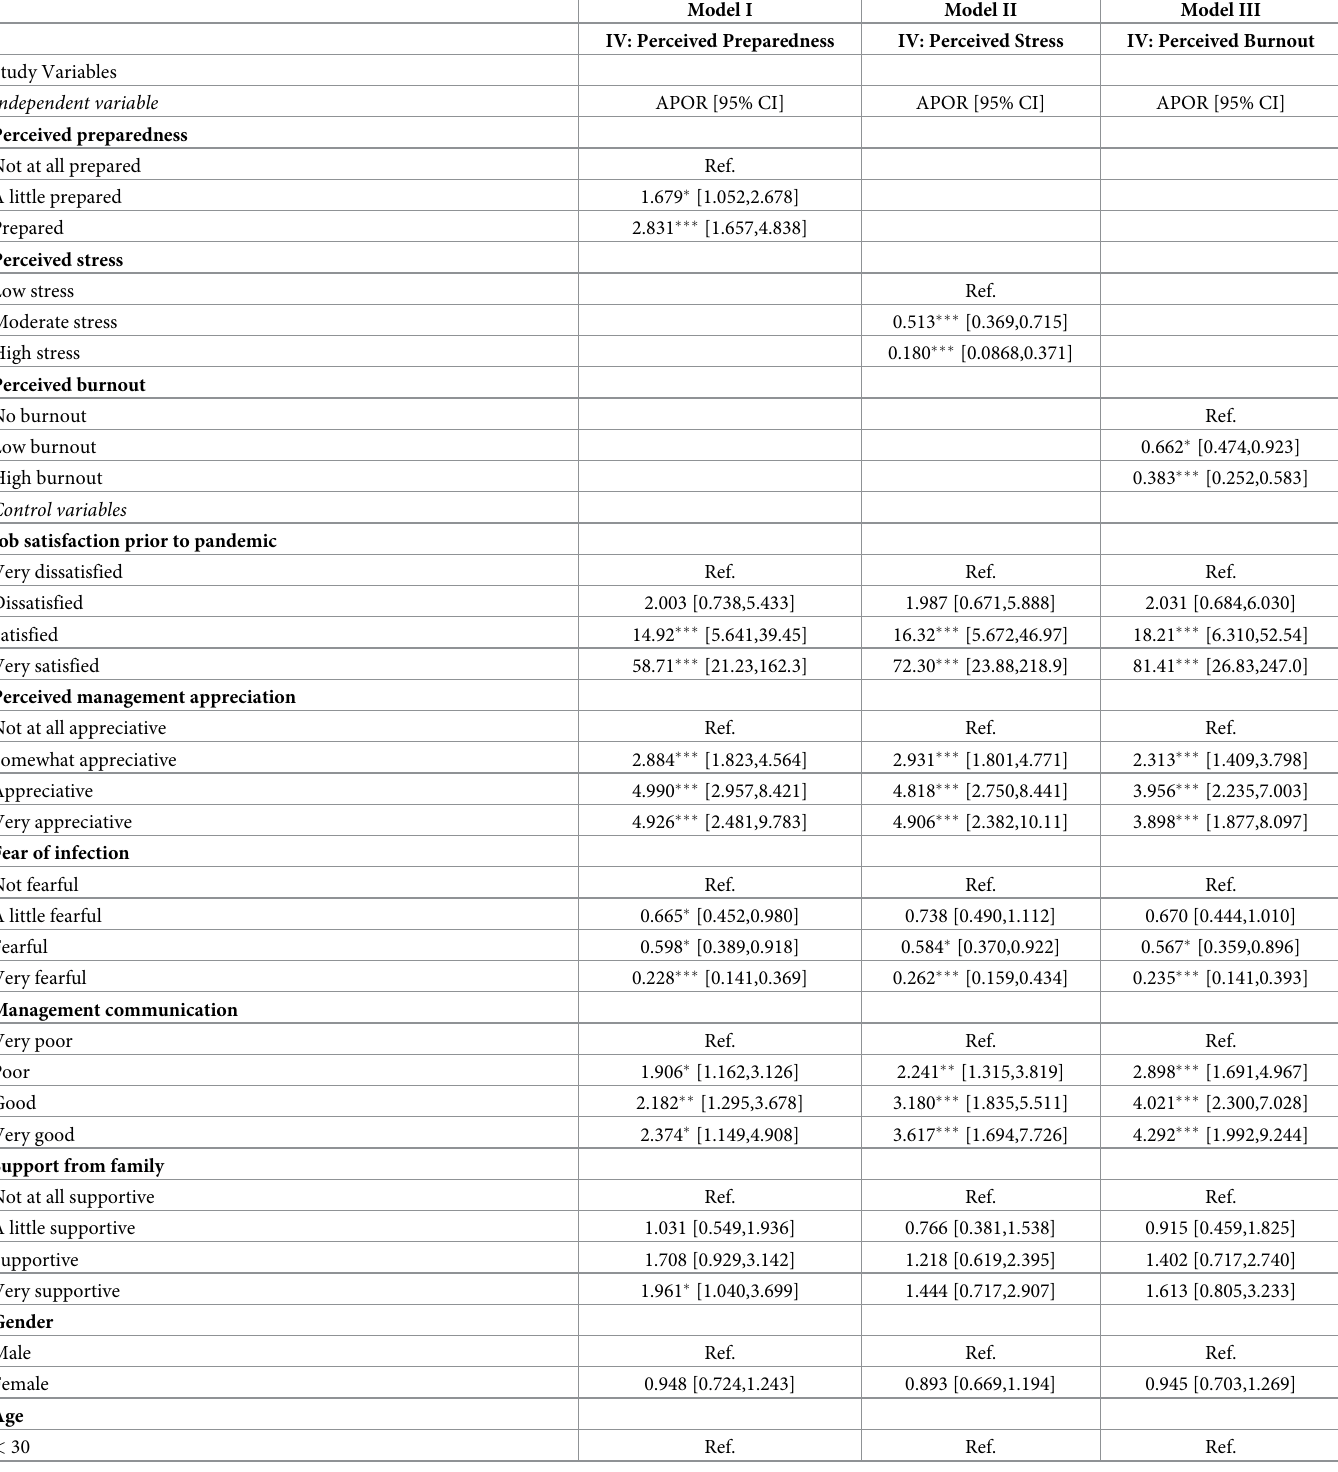
Table 3. Multivariable model showing the association between three IVs [perceived preparedness, burnout, and stress] and current job satisfaction, controlling for sociodemographic